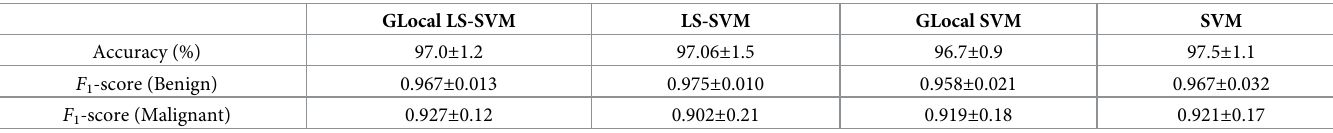
Table 5. Comparing the average error performance of the GLocal LS-SVM, and LS-SVM applied to the breast cancer Wisconsin (diagnostic) dataset.